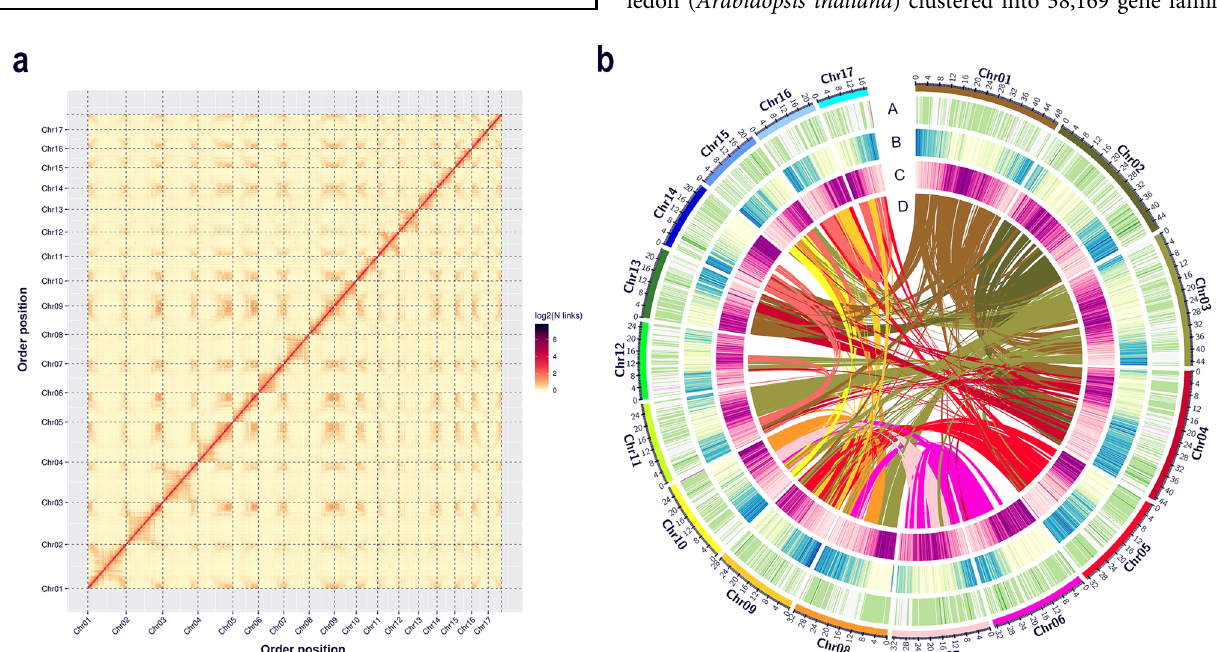
Fig. 2 Chinese wild rice genome information. a Hi-C contact data mapped on the updated Chinese wild rice genome showing genome-wide all-by-all interactions. b Overview of the Chinese wild rice genome. Ring A: distribution of GC content (green); ring B: gene density (blue); ring C: density of repeat sequences (purple); and ring D: syntenic blocks within the